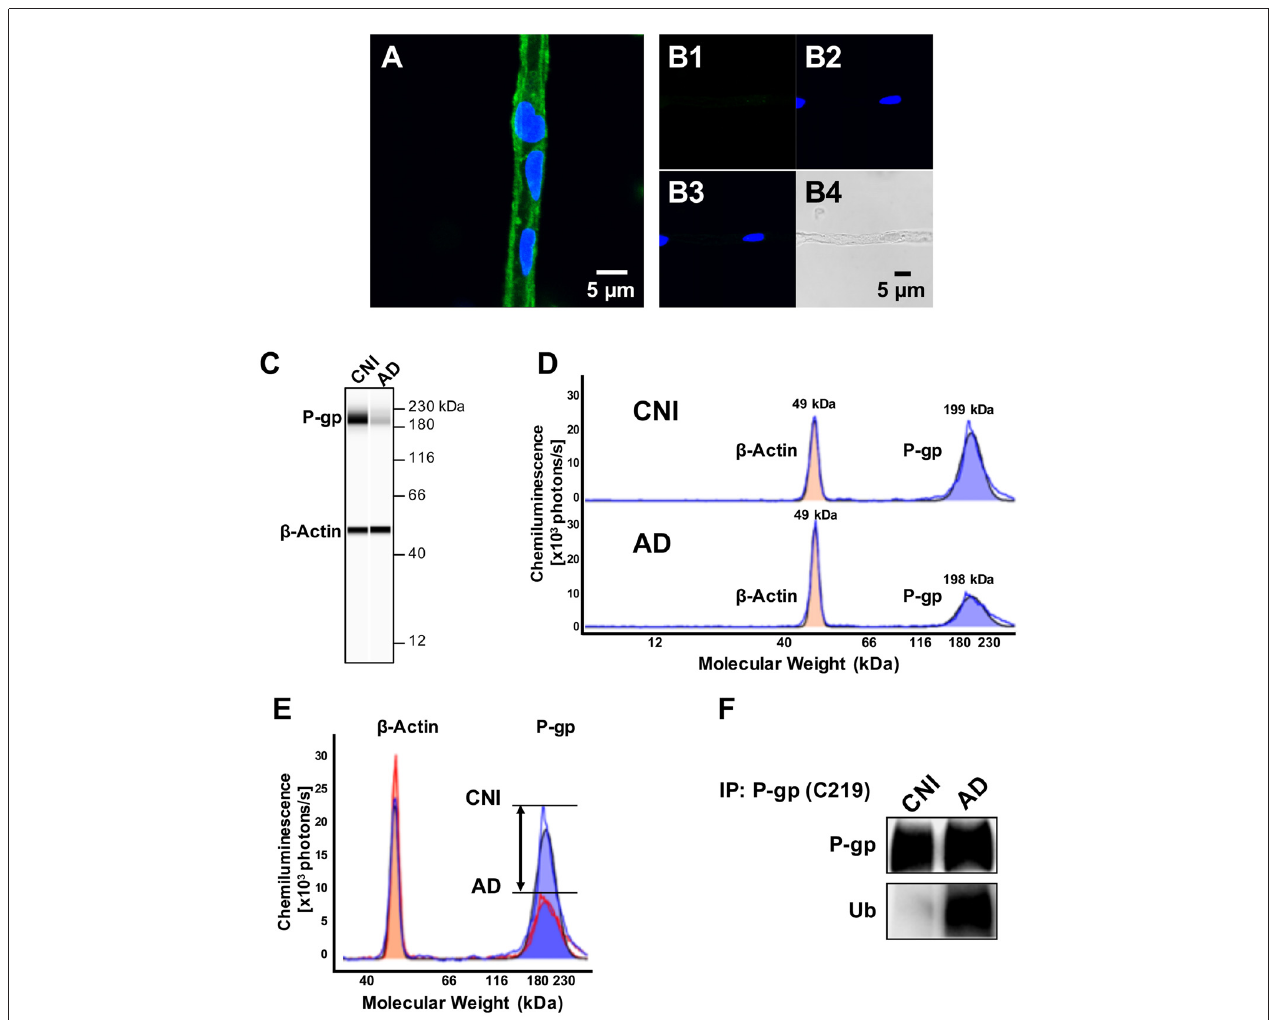
FIGURE 1 | P-glycoprotein (P-gp) protein expression levels are decreased and P-gp ubiquitination levels are increased in brain capillaries from Alzheimer’s disease (AD) patients. (A) Representative image of a P-gp-immunostained (green) brain capillary isolated from brain tissue of a cognitive normal individual (CNI); nuclei were counterstained with DAPI (blue). (B) Negative control (no primary antibody): (B1 ; green channel); (B2 ; blue channel); (B3 ; overlay of green and blue channel) and (B4 ; transmitted light channel). (C) Representative WES TM image and (D) electropherogram showing reduced P-gp (blue shaded area) protein expression levels in brain capillaries isolated from human brain tissue (frontal cortex) of AD patients ( n = 3) vs. CNIs ( n = 3). (E) Overlay of electropherograms displayed in (D) show a reduction in the area under the curve (AUC) that represents P-gp protein expression levels (blue shaded area) in brain capillaries from AD patients (red line) relative to CNI (blue line). In contrast, β -actin levels (orange shaded area) in brain capillaries from AD patients (red line) and CNI (blue line) were the same. (F) Western blot showing that ubiquitin levels in P-gp-immunoprecipitates are increased in capillaries from AD patients compared to those from CNI.